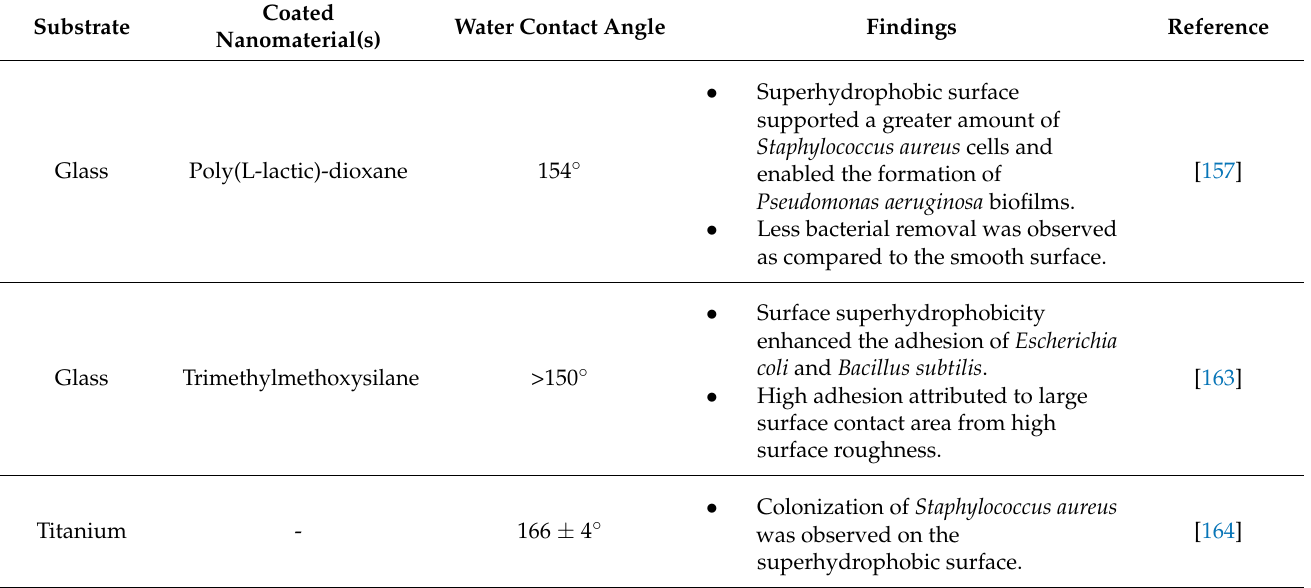
Table 5. Examples of contradicting findings on the anti-biofilm potential of superhydrophobic surfaces.